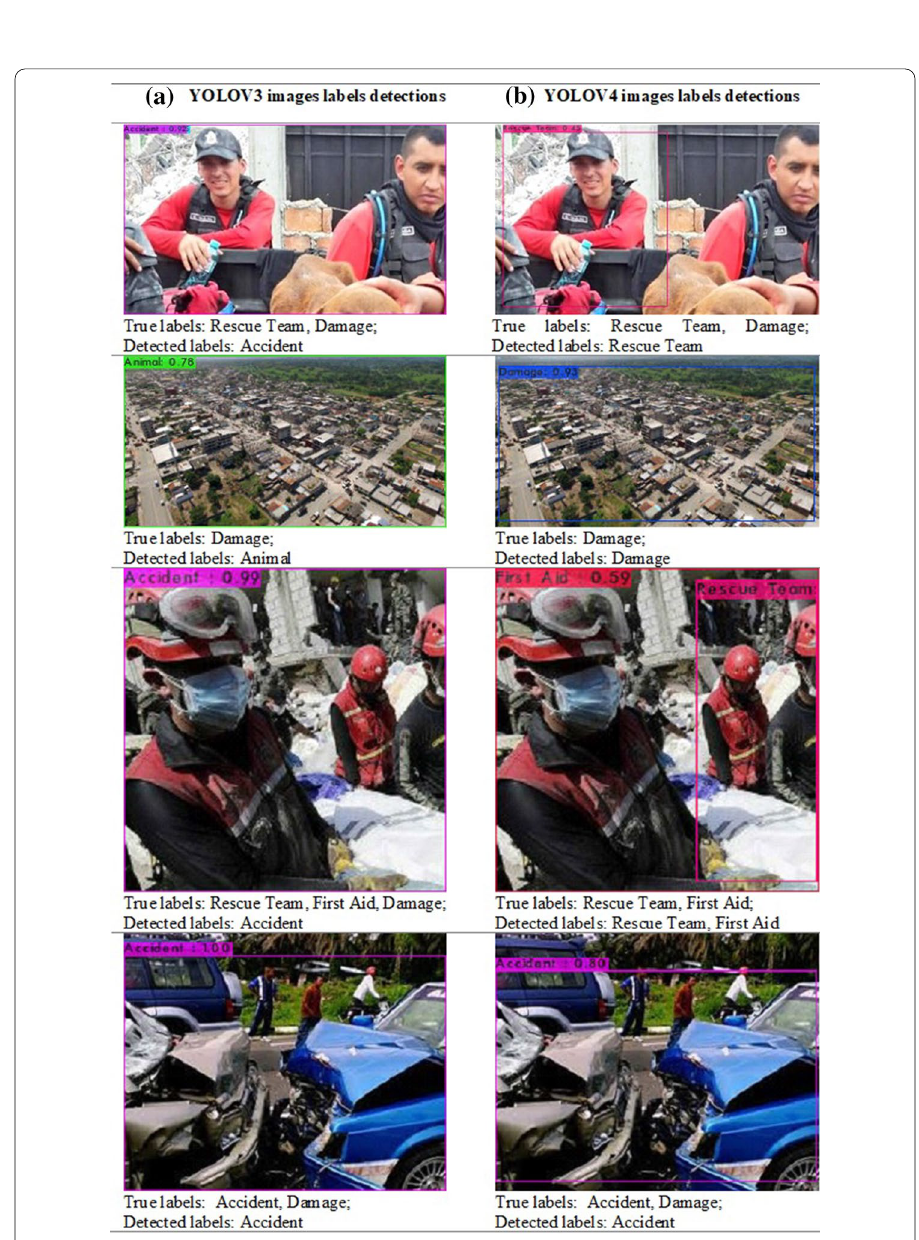
Fig. 7 Comparison of the object detection quality of YOLOv3 and